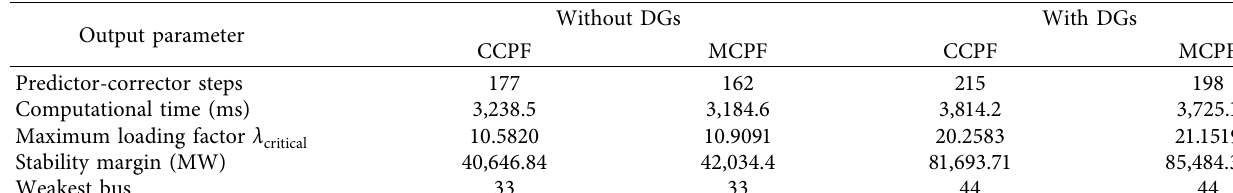
Figure 12: The P-V curve at the load bus 44 during the load-increasing process: (a) without DGs and (b) with DGs. Table 4: Comparisons between CCPF and MCPF of the IEEE 118-bus test system.